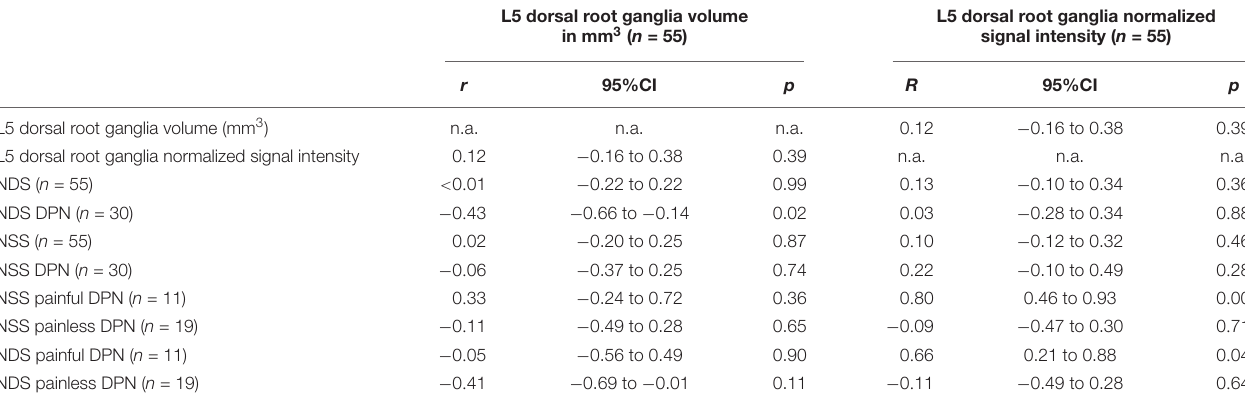
FIGURE 3 | L5 dorsal root ganglion (DRG) volume and normalized signal intensity (SI) versus neuropathy disability score (NDS) and neuropathy symptom score (NSS). (A) Correlation of NDS and L5 DRG volume in patients with diabetic polyneuropathy [DPN; ( r = –0.43; 95%CI = –0.66 to –0.14; p = 0.02)]. (B) DRG volumetry of a patient with a total L5 DRG volume of 277 mm 3 . (C) DRG volumetry of a patient with a total L5 DRG volume of 94 mm 3 . (D) Correlation of L5 DRG SI and NSS in painful DPN ( r = 0.80; 95%CI = 0.46 to 0.93; p = 0.005). (E) L5 DRG SI in a patient with severe painful DPN (SI = 0.61 ± 0.094). (F) L5 DRG SI in a patient with mild painful DPN (SI = 0.45 ± 0.054). TABLE 2 | Correlation of dorsal root ganglia volume and normalized signal intensity with clinical